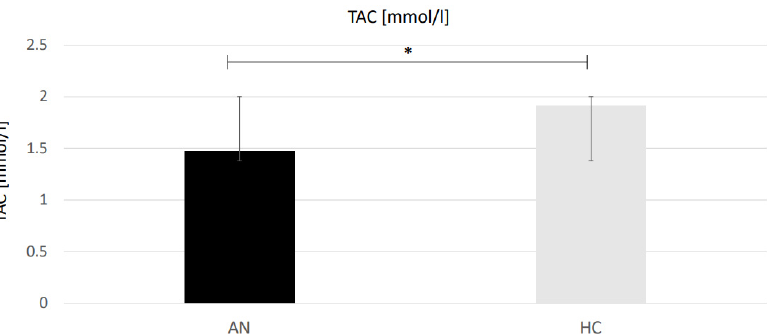
Figure 1. Differences in the antioxidative capacity between anorexia nervosa patients and controls. AN = anorexia nervosa, HC = healthy controls, TAC = total antioxidant capacity. * = significant difference, p < 0.05.